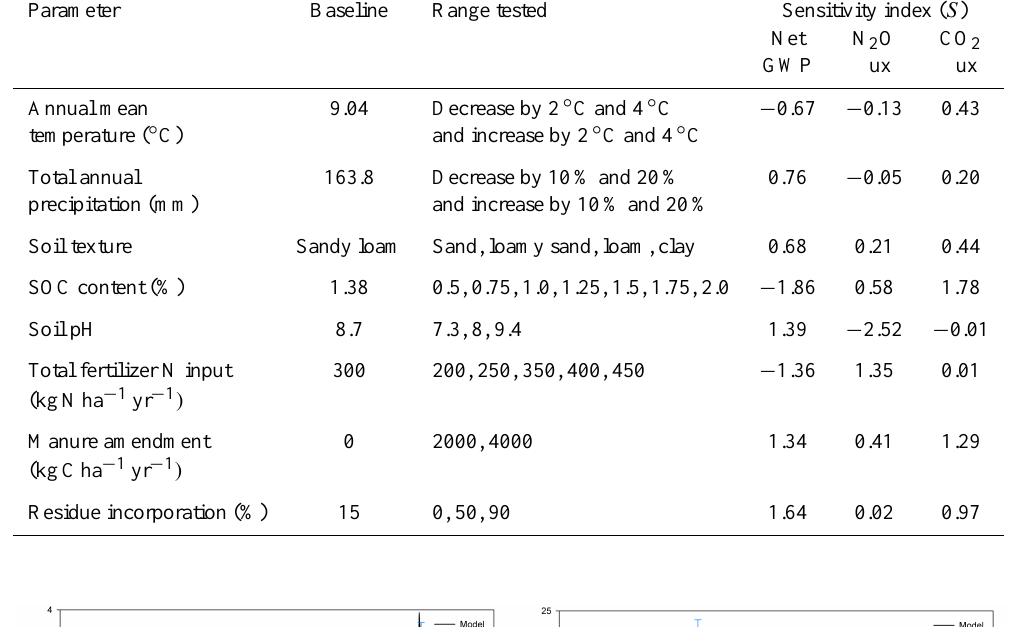
Table 4. Calculated sensitivity indices quantifying impact of the tested input parameters on output Net GWP, N 2 O and CO 2 fluxes.